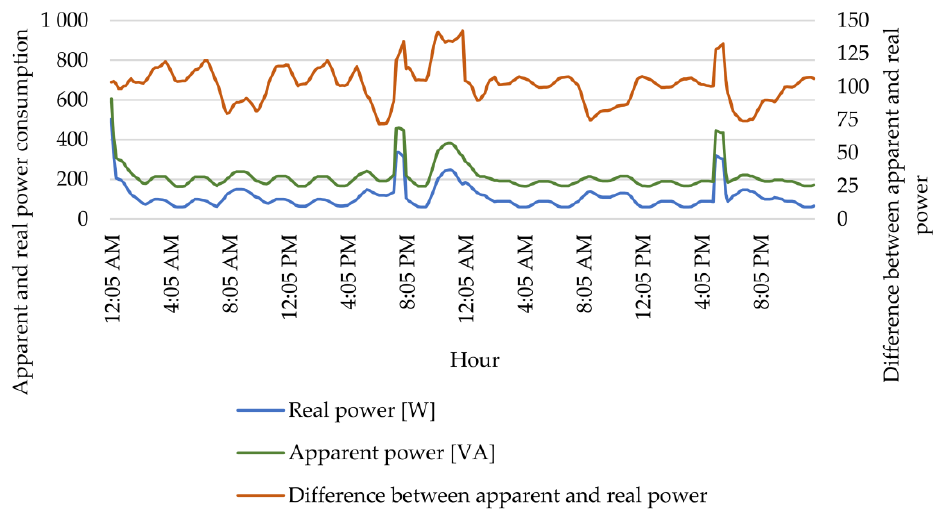
Figure 1. Graph of real and apparent power and their differences for house no. 1.